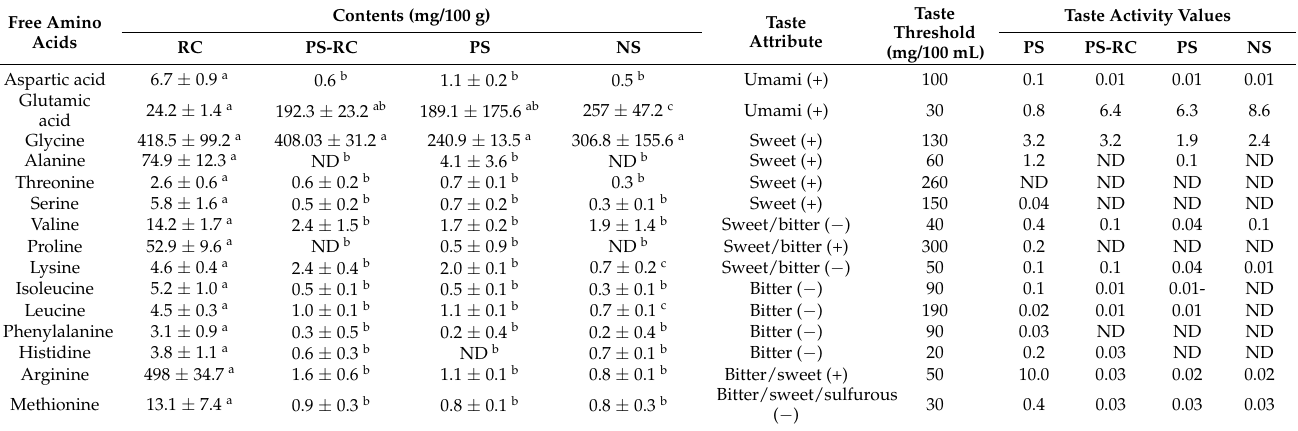
Table 4. The contents, taste attributes (+ = pleasant, − = unpleasant), taste thresholds and taste activity values of free amino acids in the snow crab leg meat and commercial imitation crab